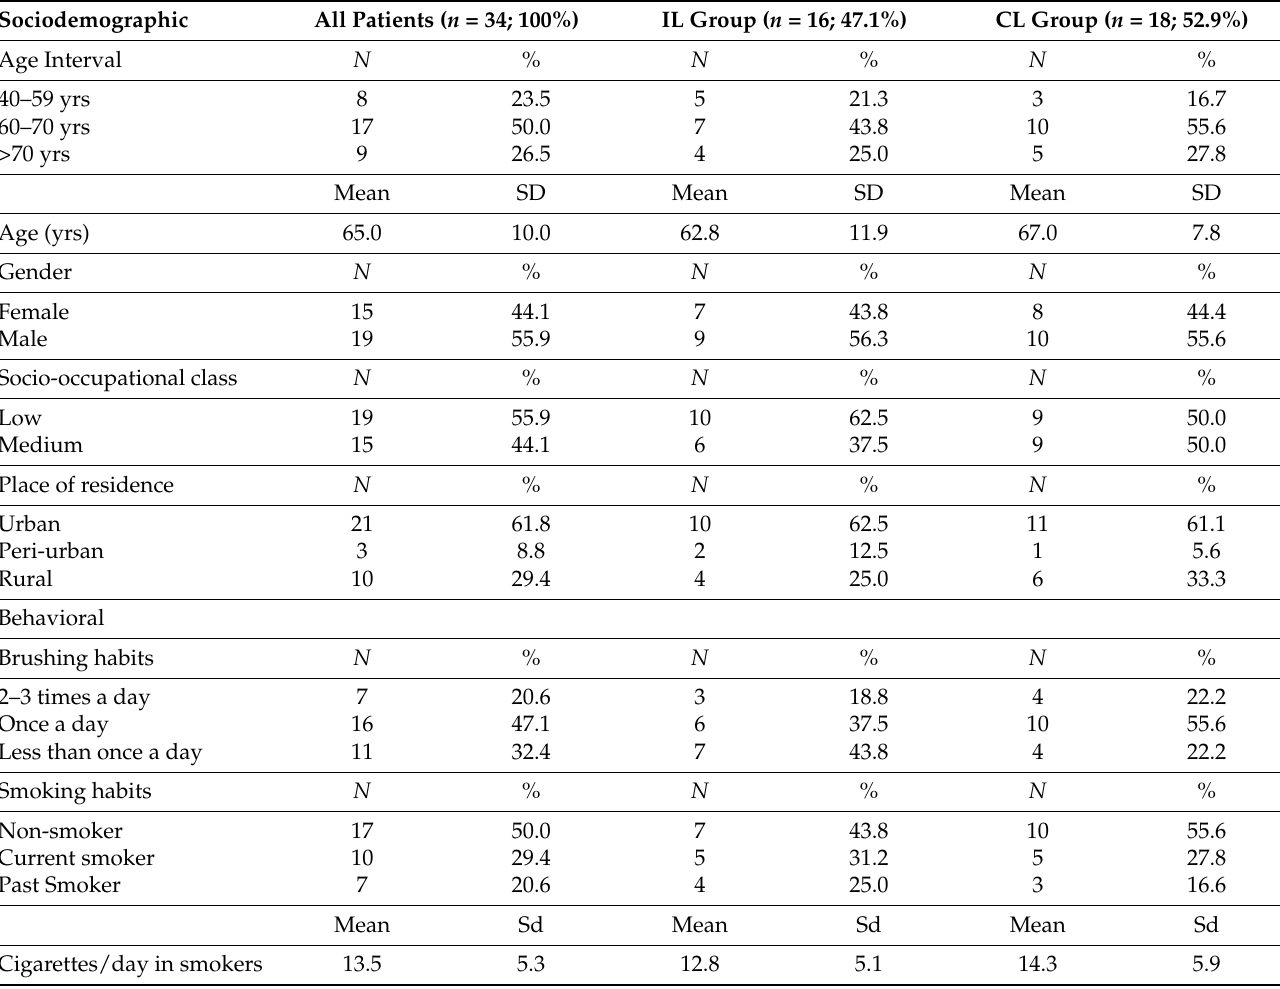
Table 1. Sociodemographic and behavioral description of the study sample ( n = 34) and among implant groups. Comparisons between groups were made by means of Student t -test and Chi Square for quantitative and nominal variables,